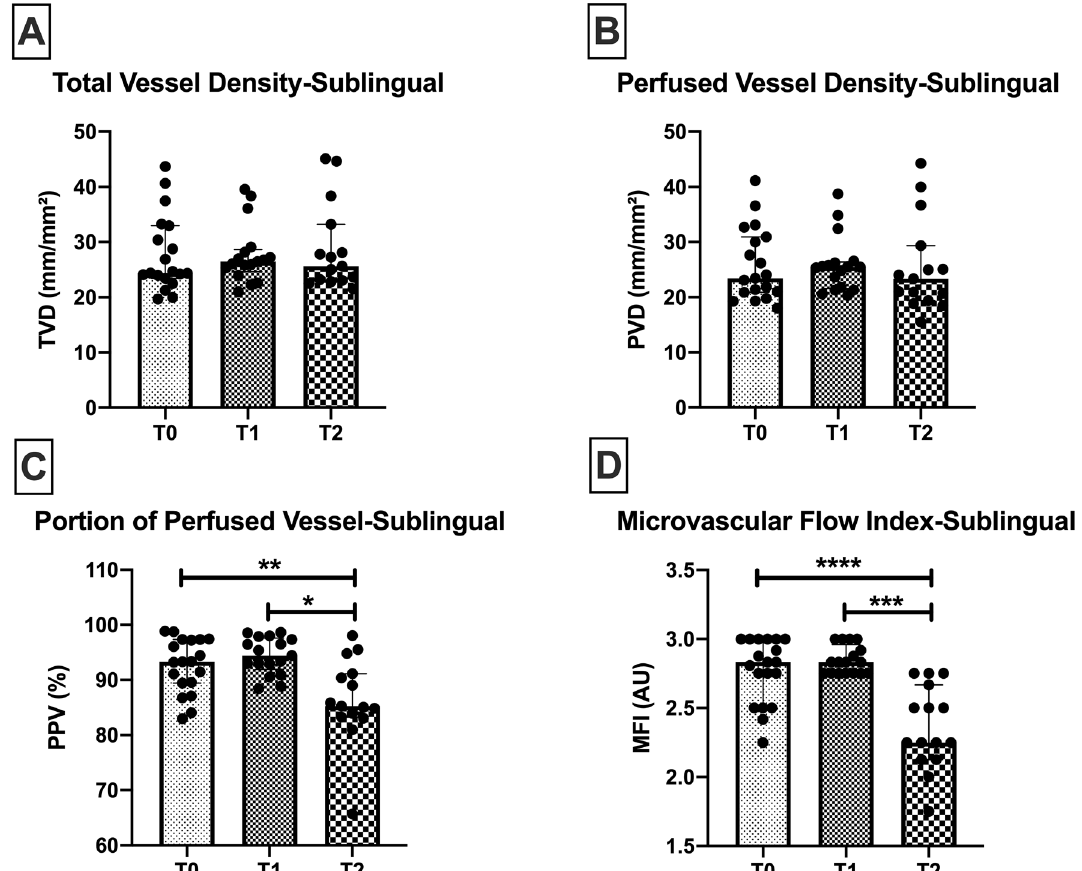
microvascular flow index (MFI) decrease 24 h after surgery. TVD total vessel density, PVD perfused vessel density, PPV portion of perfused vessel, MFI microvascular flow index. Values are represented as median [interquatile] for TVD, PVD and MFI and mean ± SD for PPV, * p < 0.05, ** p < 0.01, *** p < 0.001, **** p <